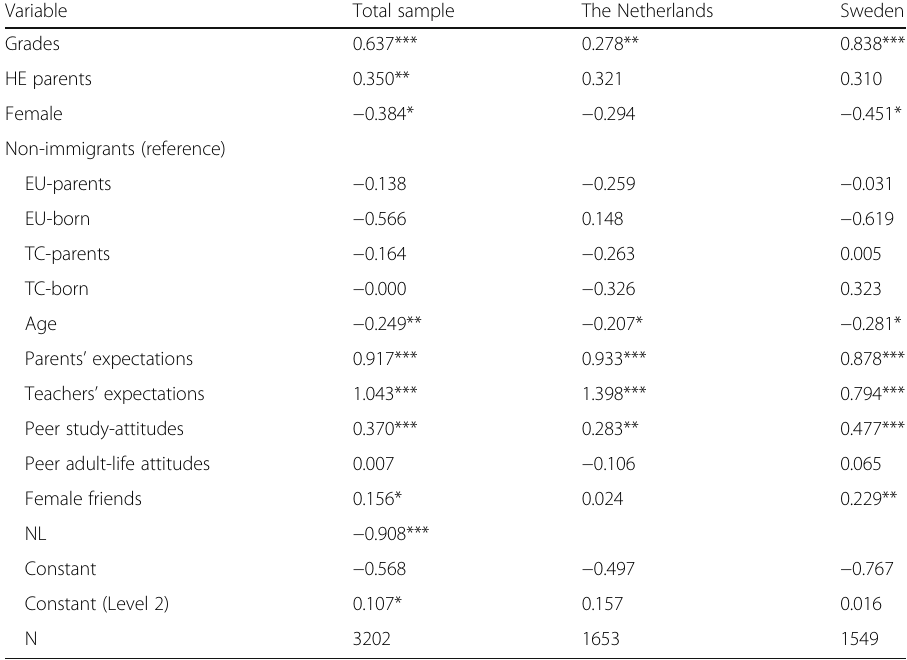
Table 4 Multi-level logit regressions. Habituated university aspirations Variable Total